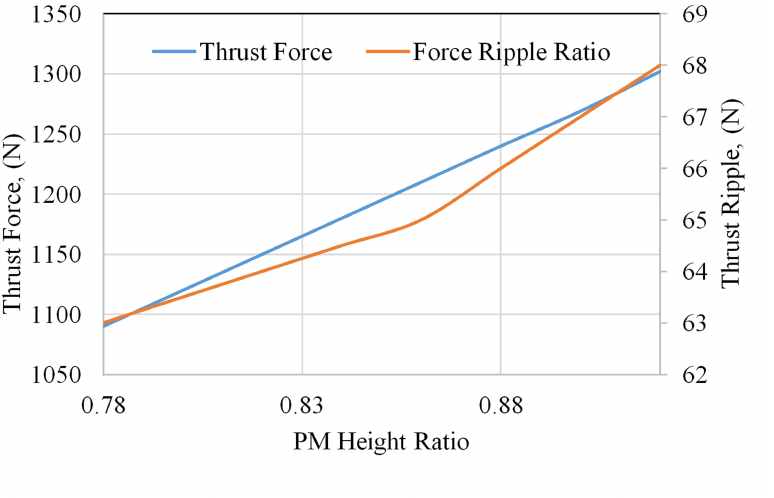
Figure 6. Force ripple and thrust force variation with PM height ratio for dual mover yokeless